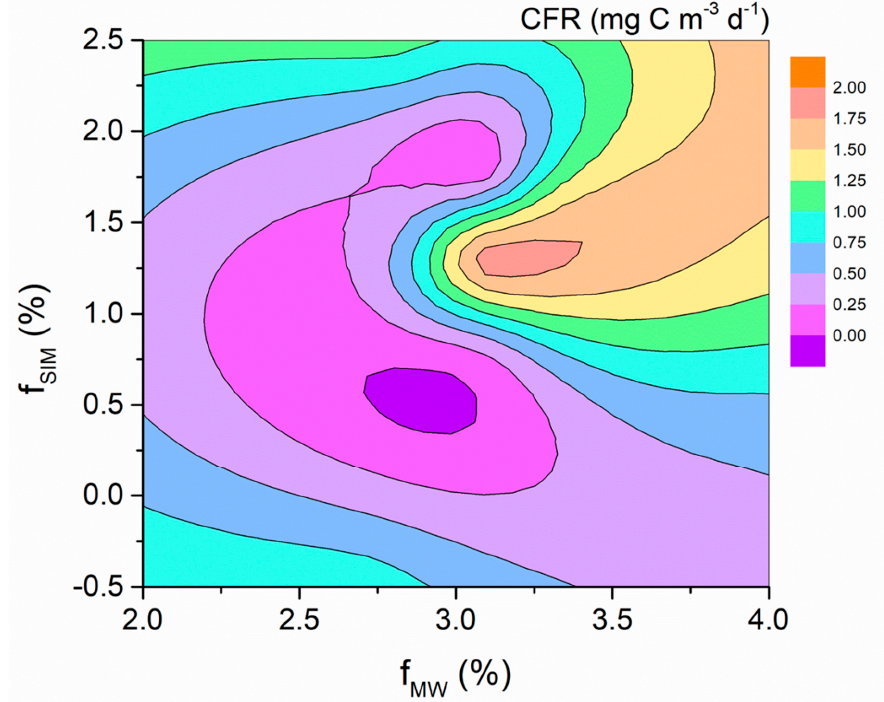
Figure 8. The CFR variations with the fractions of MW (f MW ) and SIM (f SIM ).